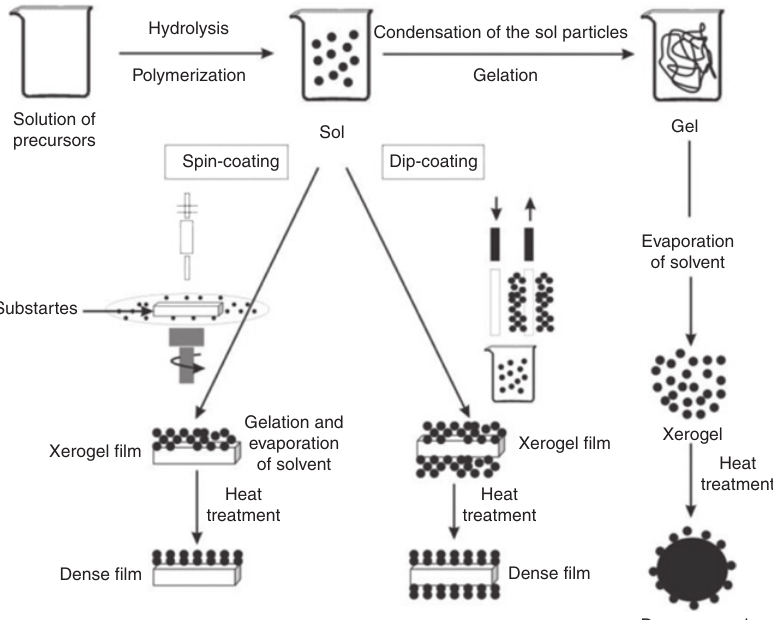
Figure 3: General scheme of possible routes to obtain thin films and powders by sol-gel technique. Reprinted with permission from Ref. [30]. Copyright 2014 Multidisciplinary Digital Publishing